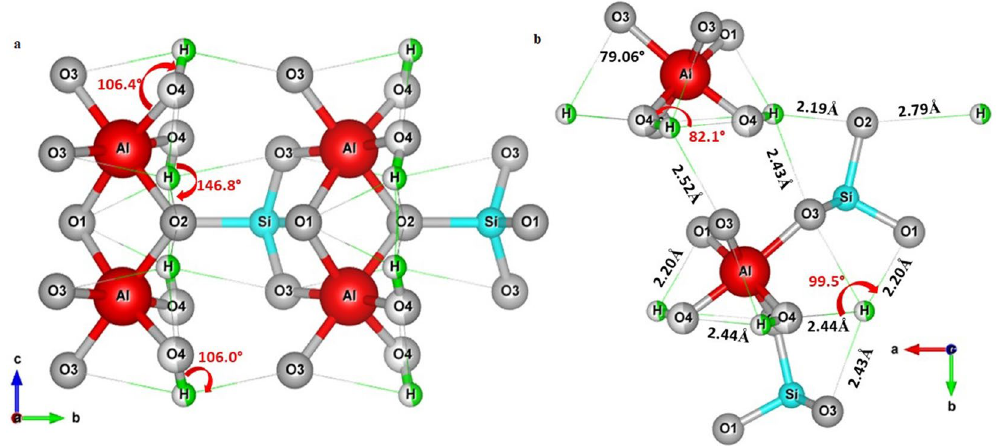
Figure 3. Hydrogen-bond system of topaz. Schematic representation of hydrogen bonding (green lines) at room temperature. Colours as in Fig. 2. The main interactions between H atoms and the surrounding polyhedral environment are viewed along the a ( a ) and c axes ( b ). The bond distance and angle between the proton site and the surrounding anions revealed the occurrence of potential H···O/F interactions, where two of them (H···O1 and H···O2) are slightly stronger than the others. The H sphere appears partially green coloured due to the OH/F substitution, according to the refined occupancies from neutron diffraction data. The structure image has been obtained using VESTA Version 3 (https ://jp-miner als.org/vesta /en/downl oad.html) 76